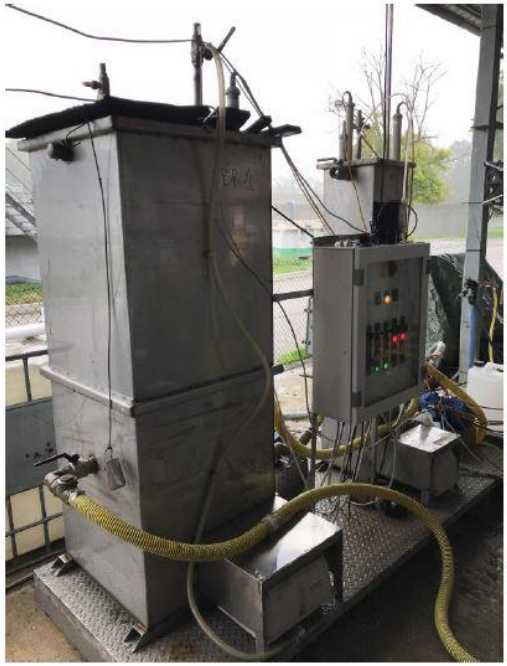
Figure 3. Sequencing batch reactor at pilot scale.